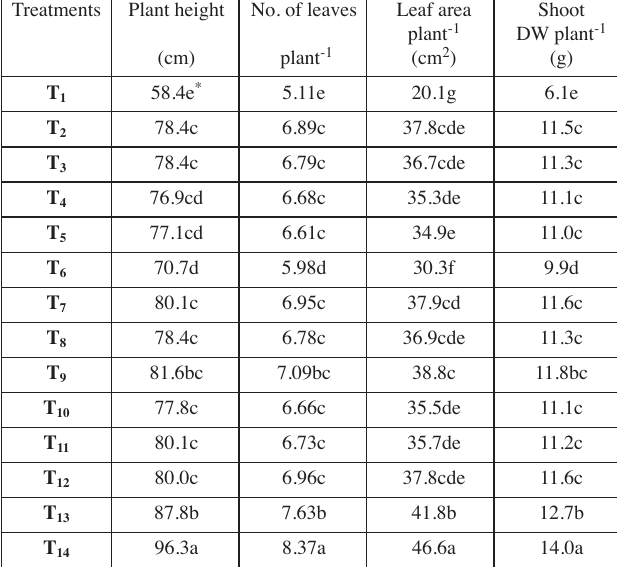
Tab. 3: Effect of N-fertilizer form applications on plant height, number (No.) of leaves plant -1 , leaf area plant -1 , and shoot dry weight (DW) plant -1 of wheat grown under saline soil